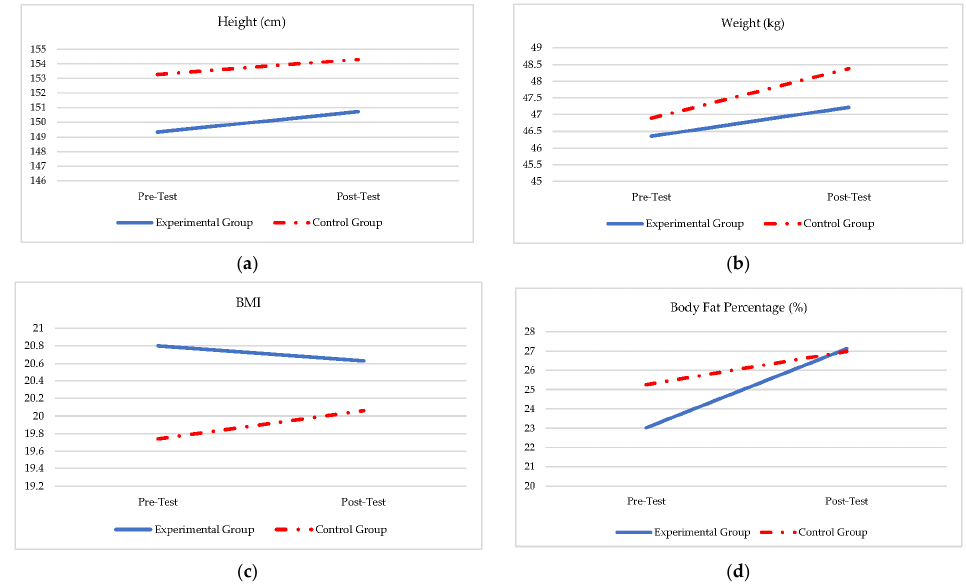
Figure 2. ( a – d ) : Group interaction over time regarding the anthropometric measurements. ( a ) Group × Time effect for during pre- and post-test ( f = 1.70; p = 0.195). ( b ) Group × Time effect during pre- and post-test ( f = 20.61; p = 0.232). ( c ) Group × Time effect during pre- and post-test ( f = 1.8; p = 0.176). ( d ) Group × Time effect during pre- and post-test ( f = 7.64; p = 0.007).